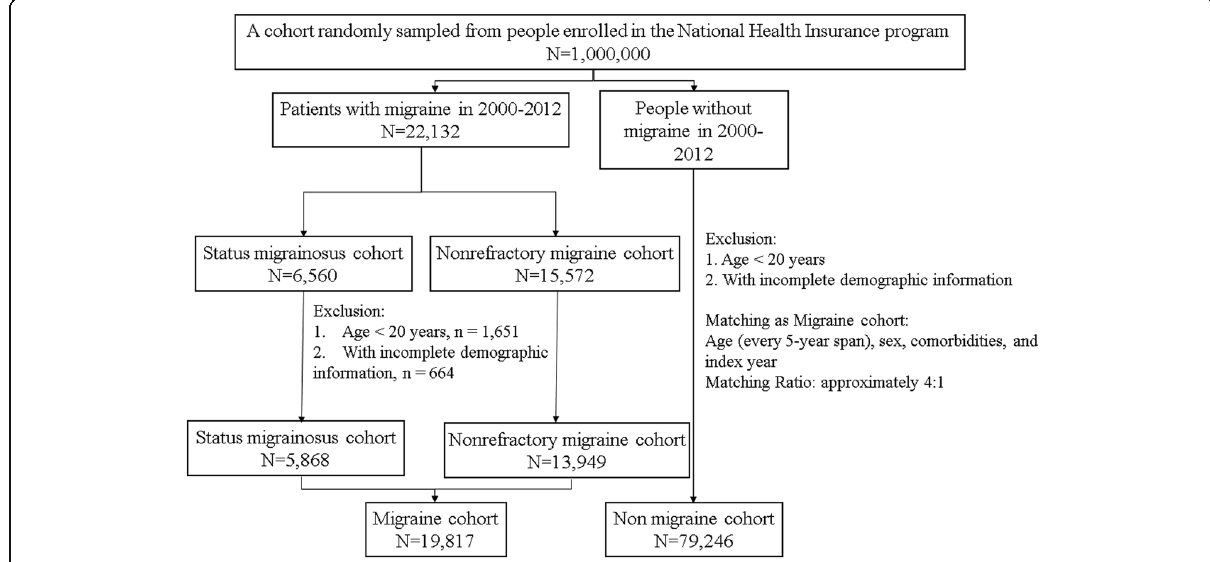
Fig. 1 The flowchart of participant selection in the study